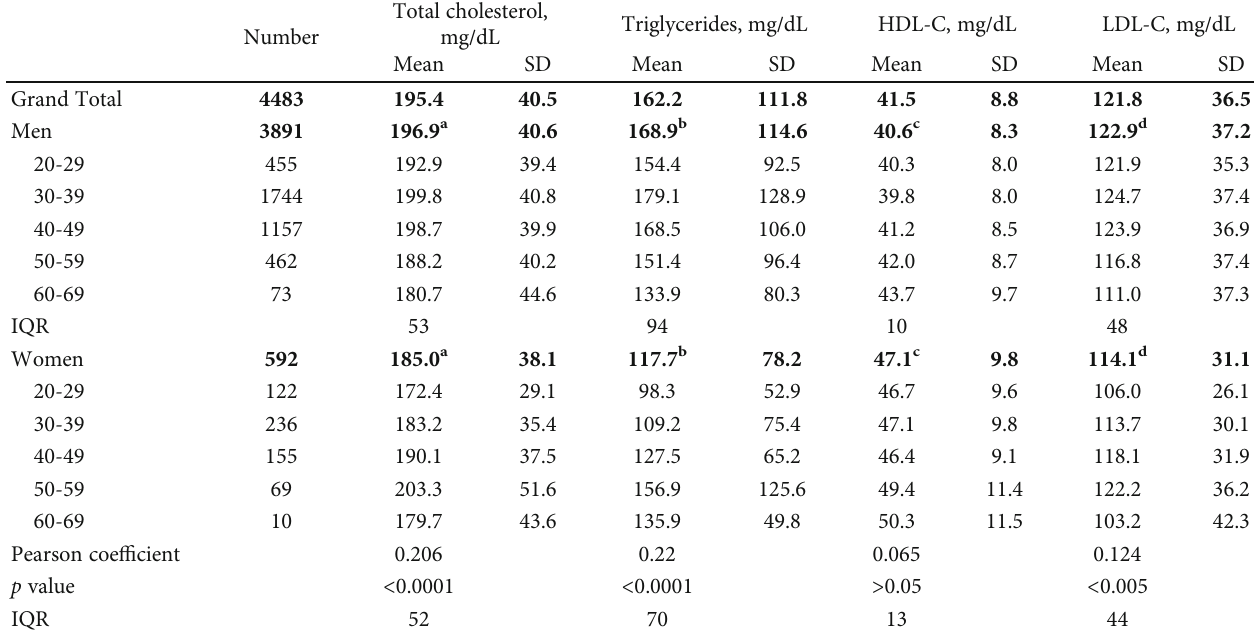
Table 1: Mean serum lipids among Indian expatriates in Qatar, by gender and age. Total cholesterol, Number mg/dL